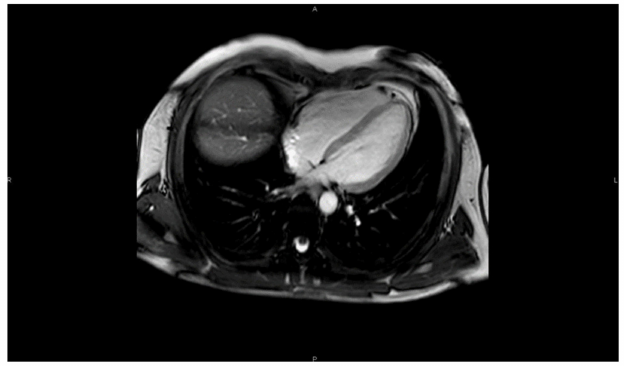
Figure 9. CMR image 4CH view of the heart.